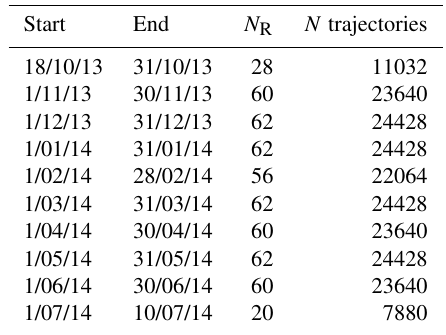
Table 3. The start and end dates of the particle tracking period used to estimate monthly residence times in the Gulf of Manfredonia. Particles were released at 394 initial positions in the Gulf of Man- fredonia, between the start and end dates, re-released every 12h and tracked for 30 days. N R denotes the number of releases and N tra- jectories the total number of trajectories for each month defined as N R × 394. Note that in July particles were tracked for 20 days due to large gaps in the HF radar velocity